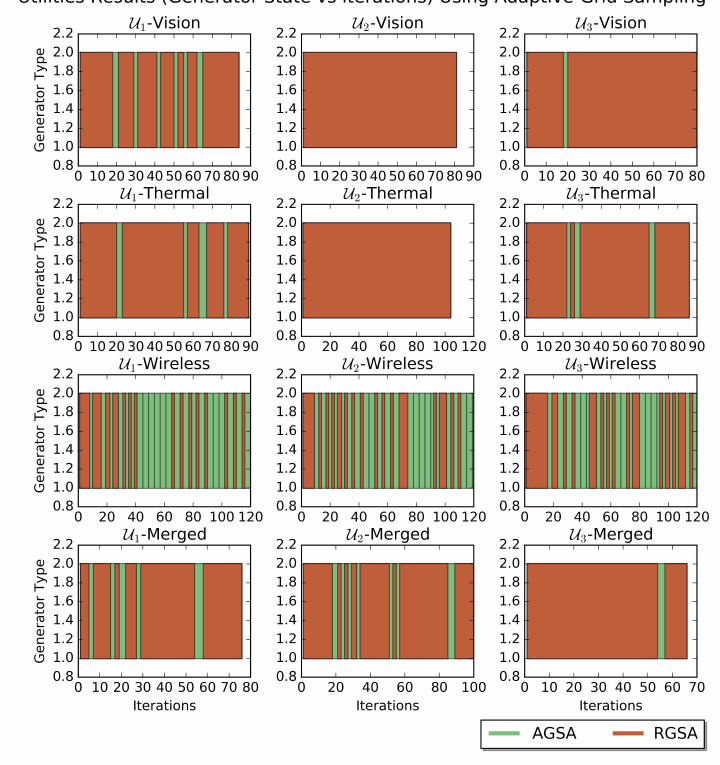
Figure 15. Generator states vs. iterations using Adaptive Grid Sampling